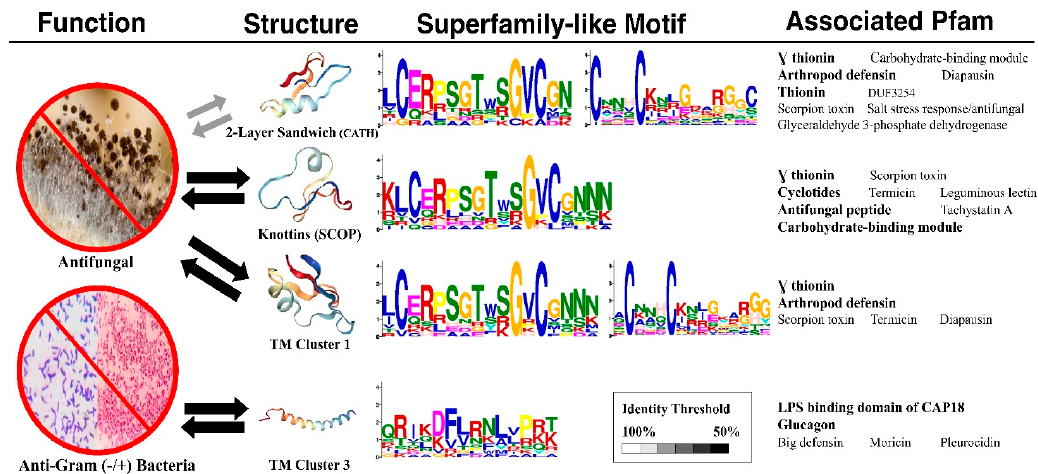
Figure 7. AMP structure–function enrichments associated with sequence motifs and Pfams.